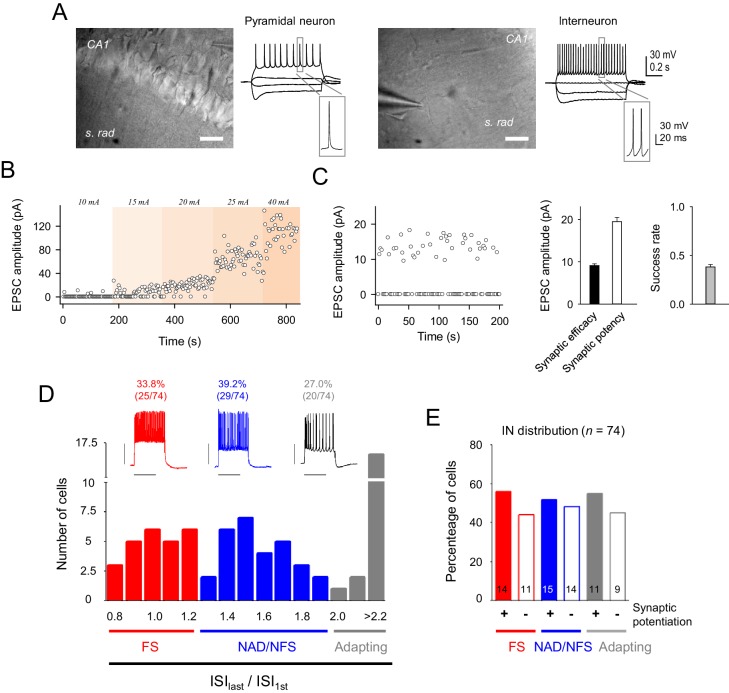
Electrophysiological properties of recorded cells and synaptic currents evoked by minimal stimulation.(A) Infrared differential interference contrast images of a CA1 pyramidal neuron (left) and an interneuron (right), with their representative voltage responses to hyper and depolarizing current pulses. Scale bar, 40 µm. (B) Time course of EPSC peak amplitude of single synapse stimulation while increasing stimulation intensity. Note the step-like activation of larger responses to small changes in stimulus intensity. (C) Left, EPSC amplitudes (failures and successes) from a representative CA3-CA1 single synapse recorded from a CA1 pyramidal neuron. Note the high number of transmission failures and the relatively low and constant EPSC amplitude, which are indicative of putative single synapse activity. Note that stimulation intensity was unchanged for the entire experiment. Right, summary of synaptic transmission parameters from representative recordings evoked by minimal stimulation: synaptic efficacy (mean amplitude of all EPSCs, including failures), synaptic potency (mean EPSC amplitude without failures), and mean success rate of neurotransmitter release (n = 45 synapses). (D) Top, representative firing patterns of the 3 types of recorded interneuron evoked by 700 ms depolarization pulses. Bottom, representation of the number of cells belonging to each interneuron subtype, according to their inter-spike interval (ISI) adaptation rate. (E) Proportion of interneuron that induced synaptic transmission potentiation after eliciting bursts of interneuron APs. These data indicate that the synaptic potentiation was independent of the interneuron subtypes. Error bars indicate SEM.